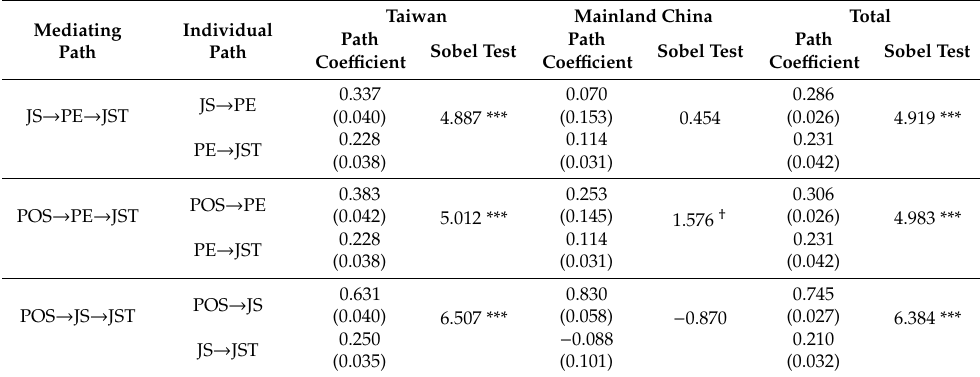
Table 5. Testing of mediating e ff ect.